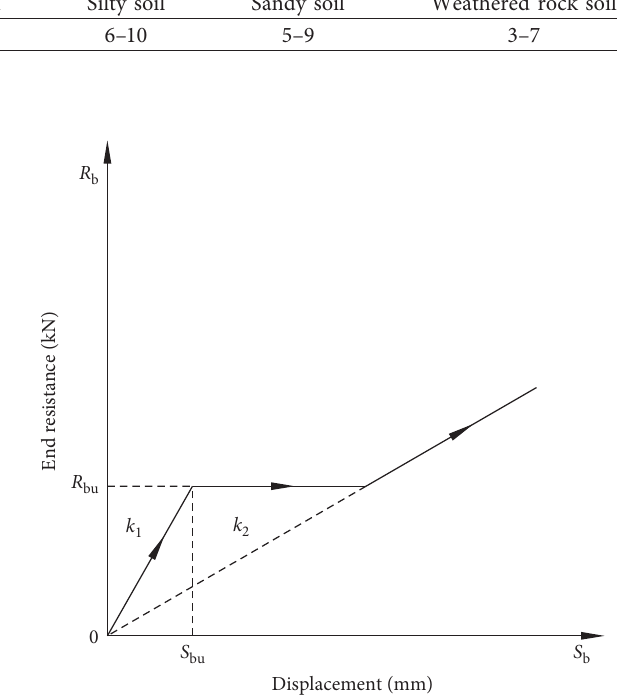
Figure 4: Illustration of load transfer function at the end of a